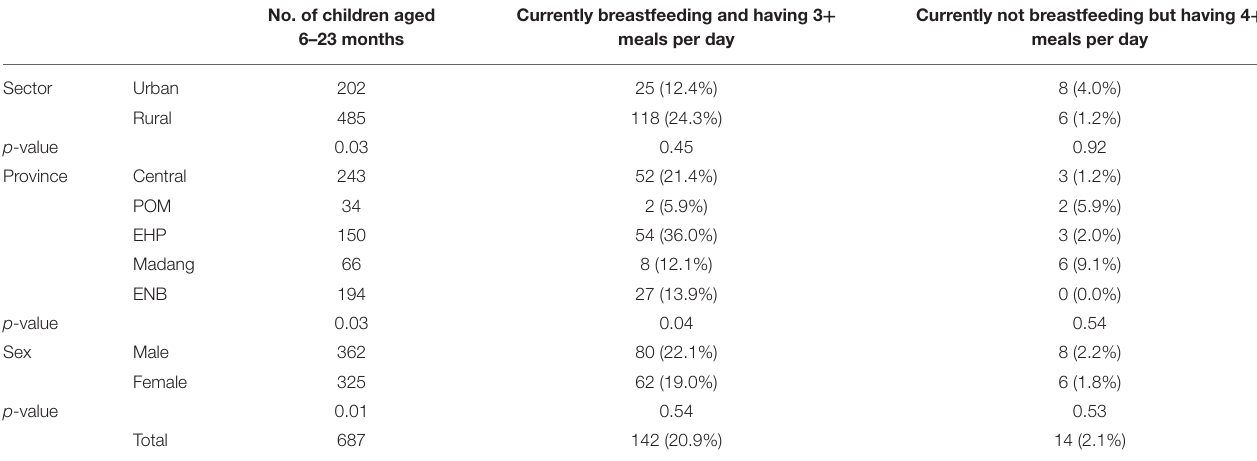
TABLE 3 | Frequency of meals among children aged 6–23 months who received solid, semisolid, and soft foods in the previous day, PNGIMR’s CHESS,